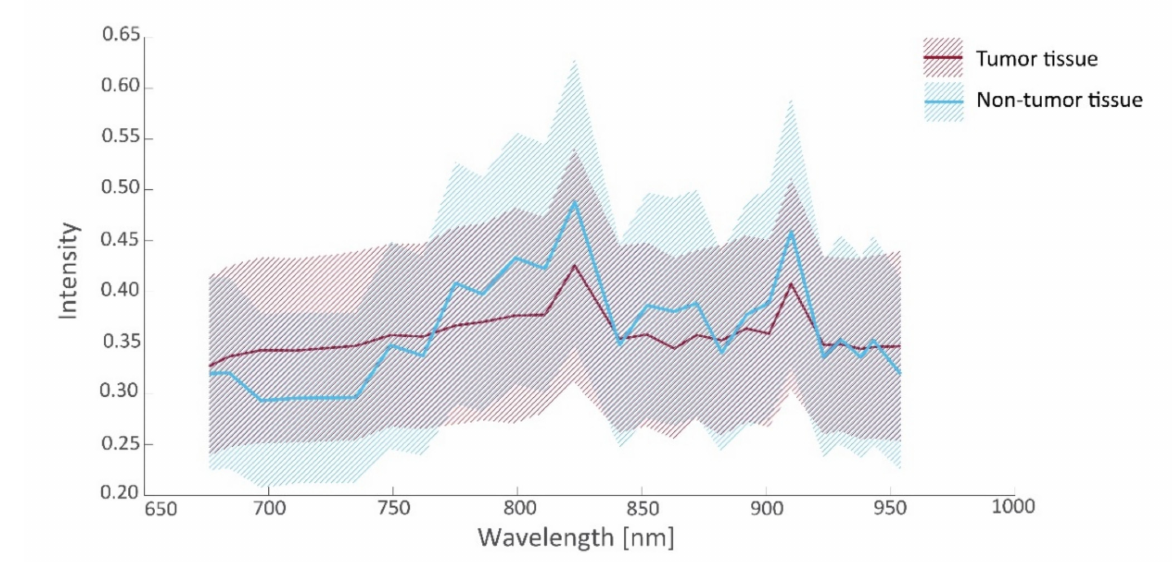
Figure 4. Intensity values (median and interquartile range (IQR)) as a function of wavelength for tumorous and non-tumorous tissues.